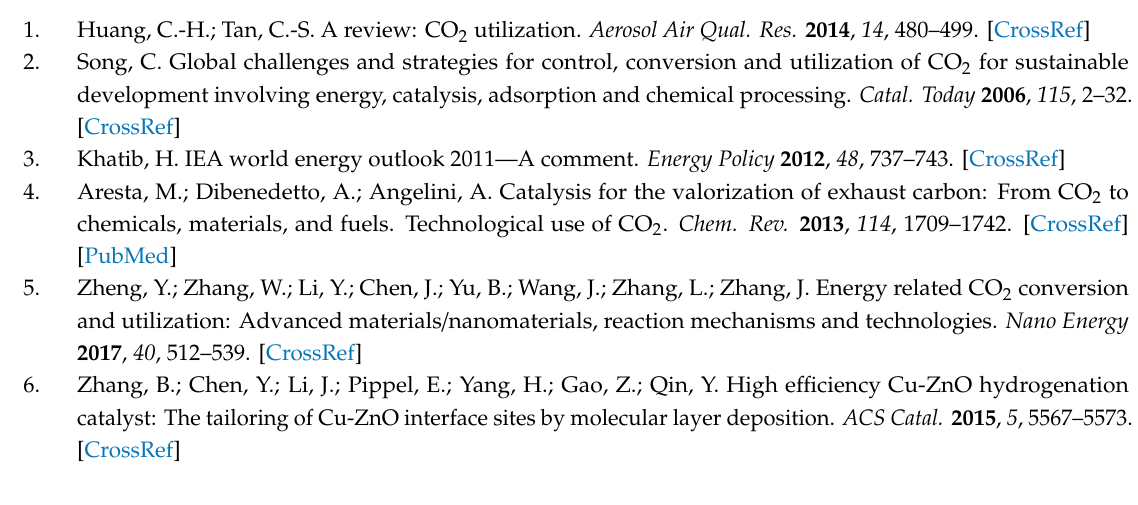
Figure S1: SEM images of pristine plate ZnO (a) and 1Cu / ZnO (b) after reduction. Figure S2: XRD patterns of ZnO:XCu model catalysts after H 2 reduction, X = 0.5, 1.0, 1.5, 3.5, 6.5. Figure S3: The correlation of the intensity ratio of E 1 (LO) to E high and the Cu doping content. Figure S4: Raman spectra of the reduced pristine ZnO and 2 ZnO:XCu model catalysts, X = 0.5, 1, 1.5, 3.5, 6.5. Figure S5: H 2 -TPD profile of pristine ZnO plate after reduction in H 2 without H 2 adsorption (detected by MS). Figure S6: H 2 -TPD profile of plate ZnO:1Cu model catalyst after reduction in H 2 without H 2 adsorption (a) and with H 2 adsorption (b), detected by TCD detector. Figure S7: CO 2 -TPD profiles of the 1Cu / ZnO model catalyst. Figure S8: SEM image of ZnO:1Cu model catalyst after RWGS stability evaluation. Table S1: The intensity ratios of E 1 (LO) to E high and wavenumber of E high for the reduced 2 2 pristine ZnO and ZnO:XCu model catalysts. Table S2: Specific surface area of calcined ZnO and Cu-ZnO model catalysts. Table S3: Surface compositional analysis of ZnO:1Cu model catalyst based on XPS